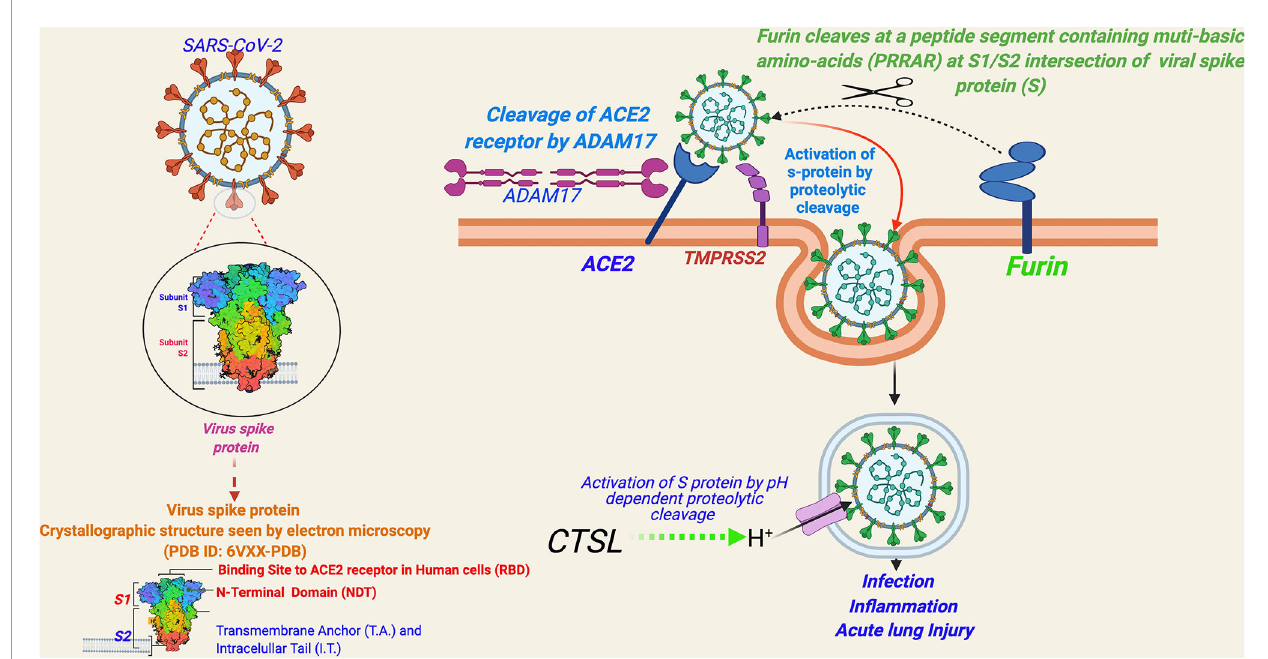
FIGURE 2 | A schema for severe acute respiratory syndrome coronavirus 2 (SARS-CoV-2) entry into human cells. [Entry of SARS-CoV-2 into human cells is mediated by a cell surface receptor angiotensin-converting enzyme-2 (ACE2). ACE2 binds to receptor-binding domain (RBD) of SARS-CoV-2 spike (S) protein. Furthermore, to enter into the host cell, the priming of the viral spike protein (S) for its fusion to host cell membrane is done by host cell proteases, which involves cleavage of ‘ S ’ protein by the serine proteases, transmembrane serine protease 2 (TMPRSS2) or Cathepsin B or L (CTS-B or -L), and furin present in the host cell membrane. CTS-B or -L) acts primarily inside the endosomes. Furin cleavage site (PRRAR), present at the intersection of S1 and S2, is considered an evolutionary gain in